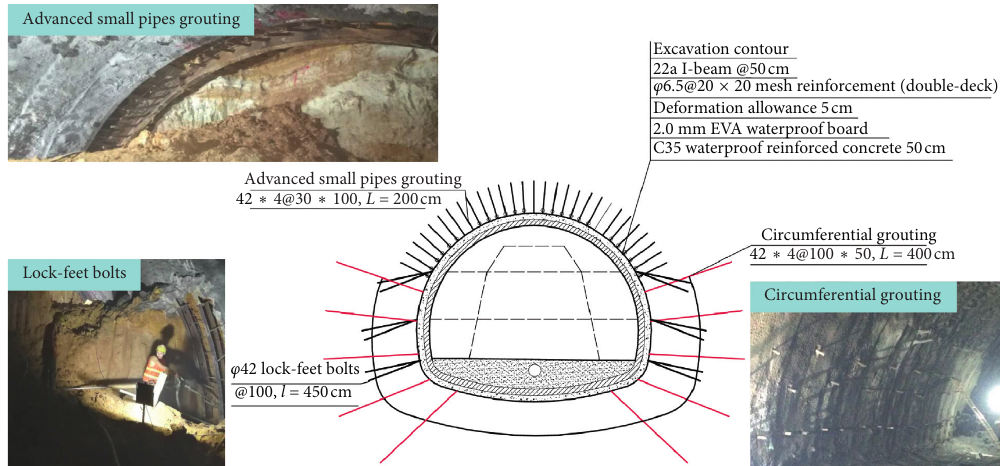
Figure 6: On-site photos and design plan of support structure.